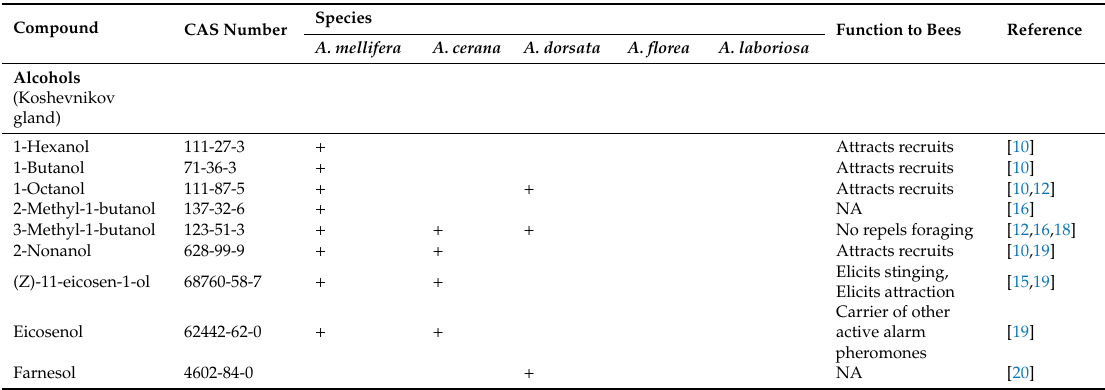
Table 1. Summary of chemical compounds in the alarm pheromone of di ff erent honey bee species in the Apis